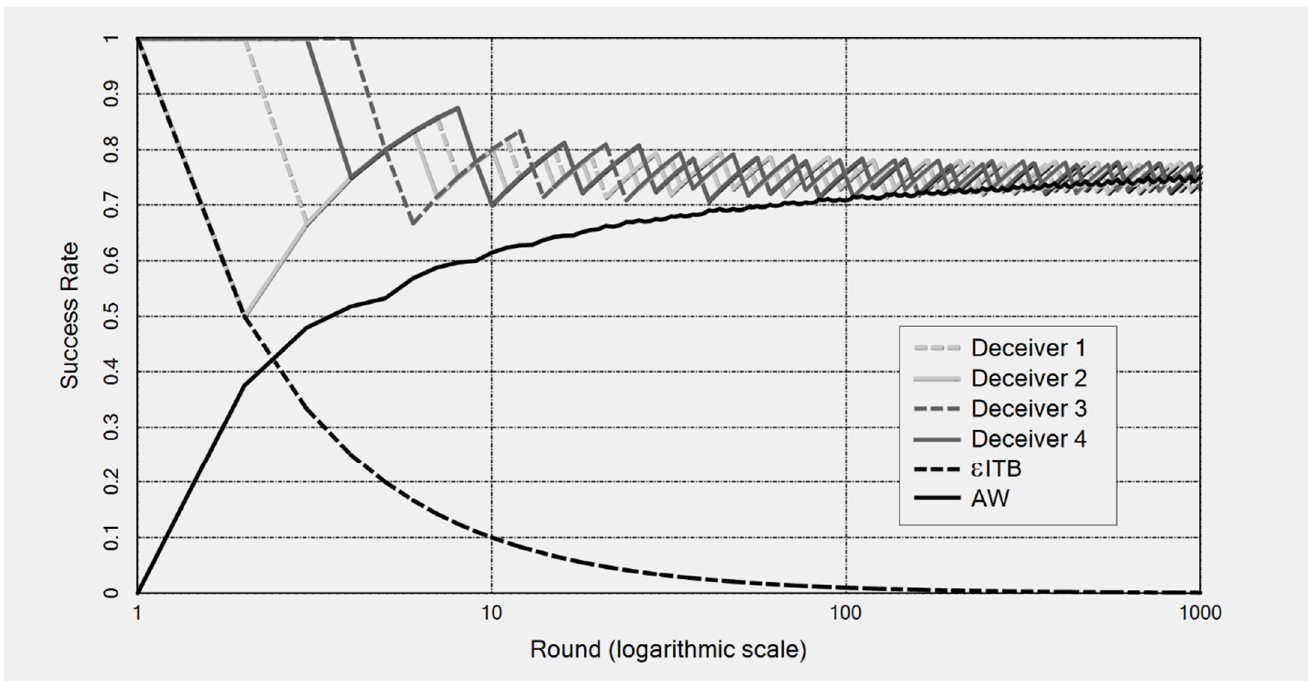
Figure 2. Simulation of a prediction game with ε ITB, AW and four deceiving “players” whose success rates oscillate with an amplitude greater than ε = 0.05.